Question: Summarize what this figure shows in one sentence.
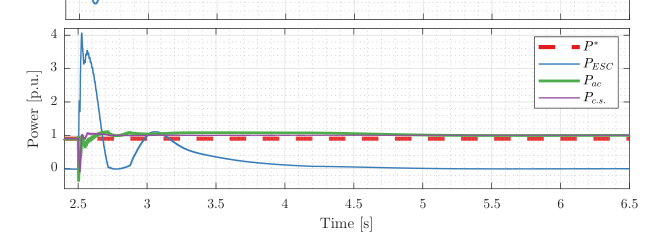
Answer: Phase-Jump of −80 deg. followed by RoCoF while discharging — Top: ac currents in [p.u.] with Is base; Middle: ac frequency in [Hz]; Bottom: active powers in [p.u.] with Sbase.